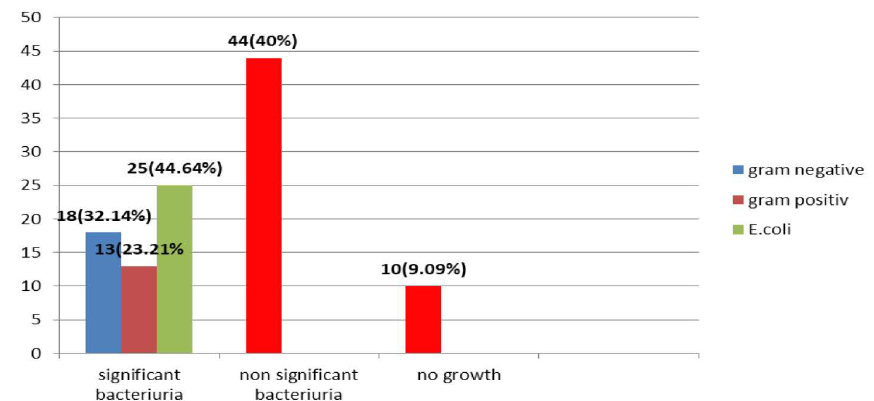
Fig. 1. The percentage of significant bacteriuria, non-significant bacteriuria and negative